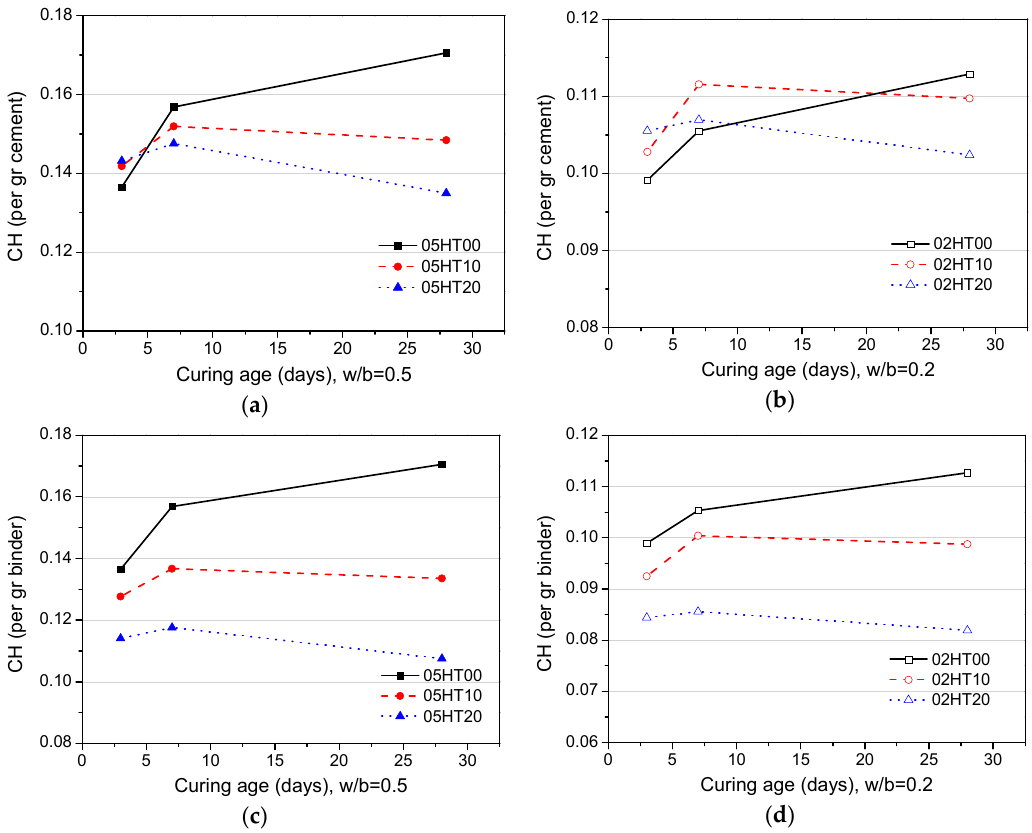
Figure 11. Calcium hydroxide (CH) content per gram ofordinary Portland cement (OPC) when ( a ) w/b = 0.5 and ( b ) w/b = 0.2. CH per gram of binder when ( c ) w/b = 0.5 and ( d ) w/b = 0.2.